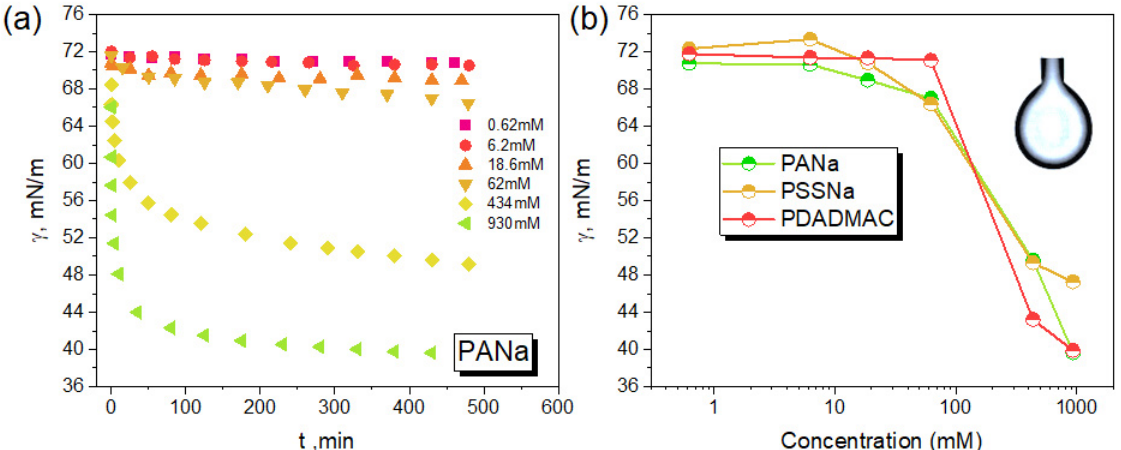
Figure 2. Dynamic surface tension ( γ ) of PANa solutions at different concentrations (in repetitive units) determined by pendant-drop measurements ( a ). Variation of the surface tension as a function of the concentration of the polyelectrolyte solution (PANa, PDADMAC, PSSNa) ( b ). Data were collected during 500 min.